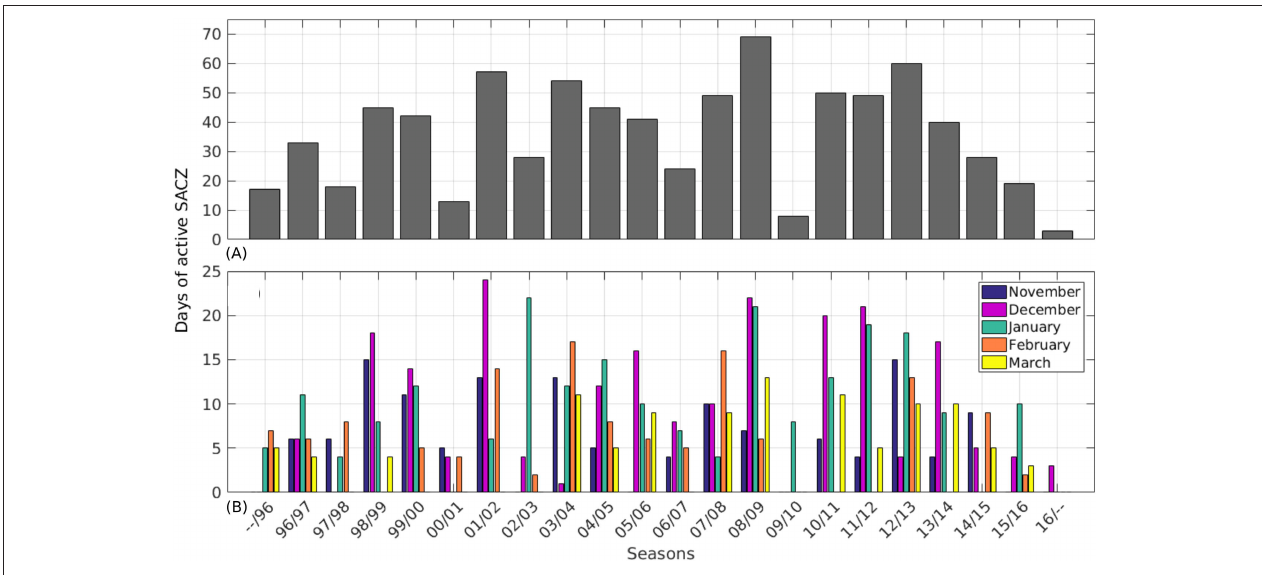
FIGURE 4 | SACZ occurrence as detected by the automated method in days. (A) Days of SACZ occurrence per 5-months season (NDJFM) and per month in (B) .